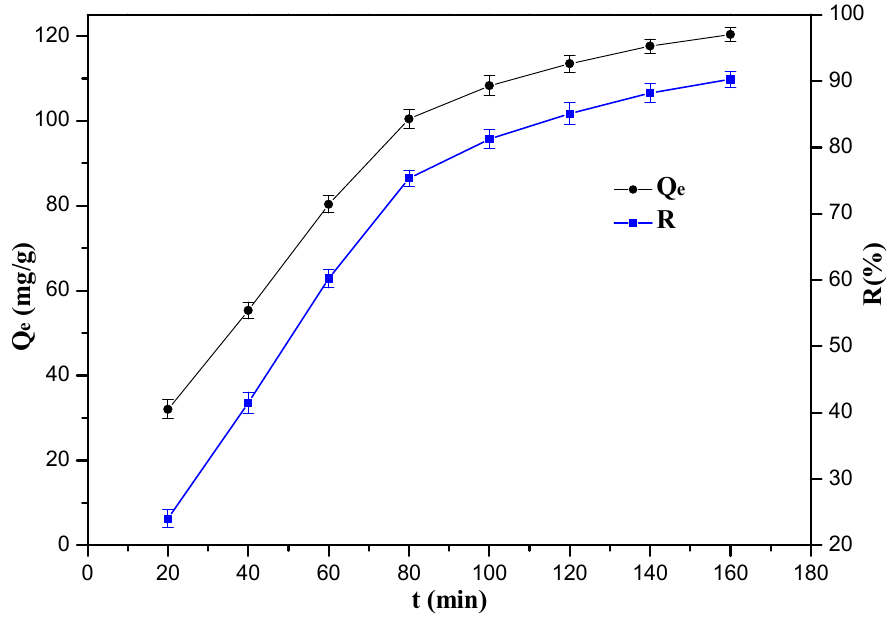
Figure 8. Effect of adsorption time on the uptake of Cr(VI) ions. The adsorption capacity (Q t ) was fitted with pseudo-first-order or pseudo-second- order method with the same time intervals, and the calculated models are expressed in Equations [45].